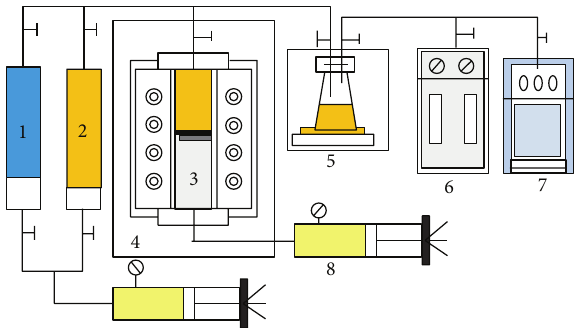
Figure 1: Schematic diagram of the experimental